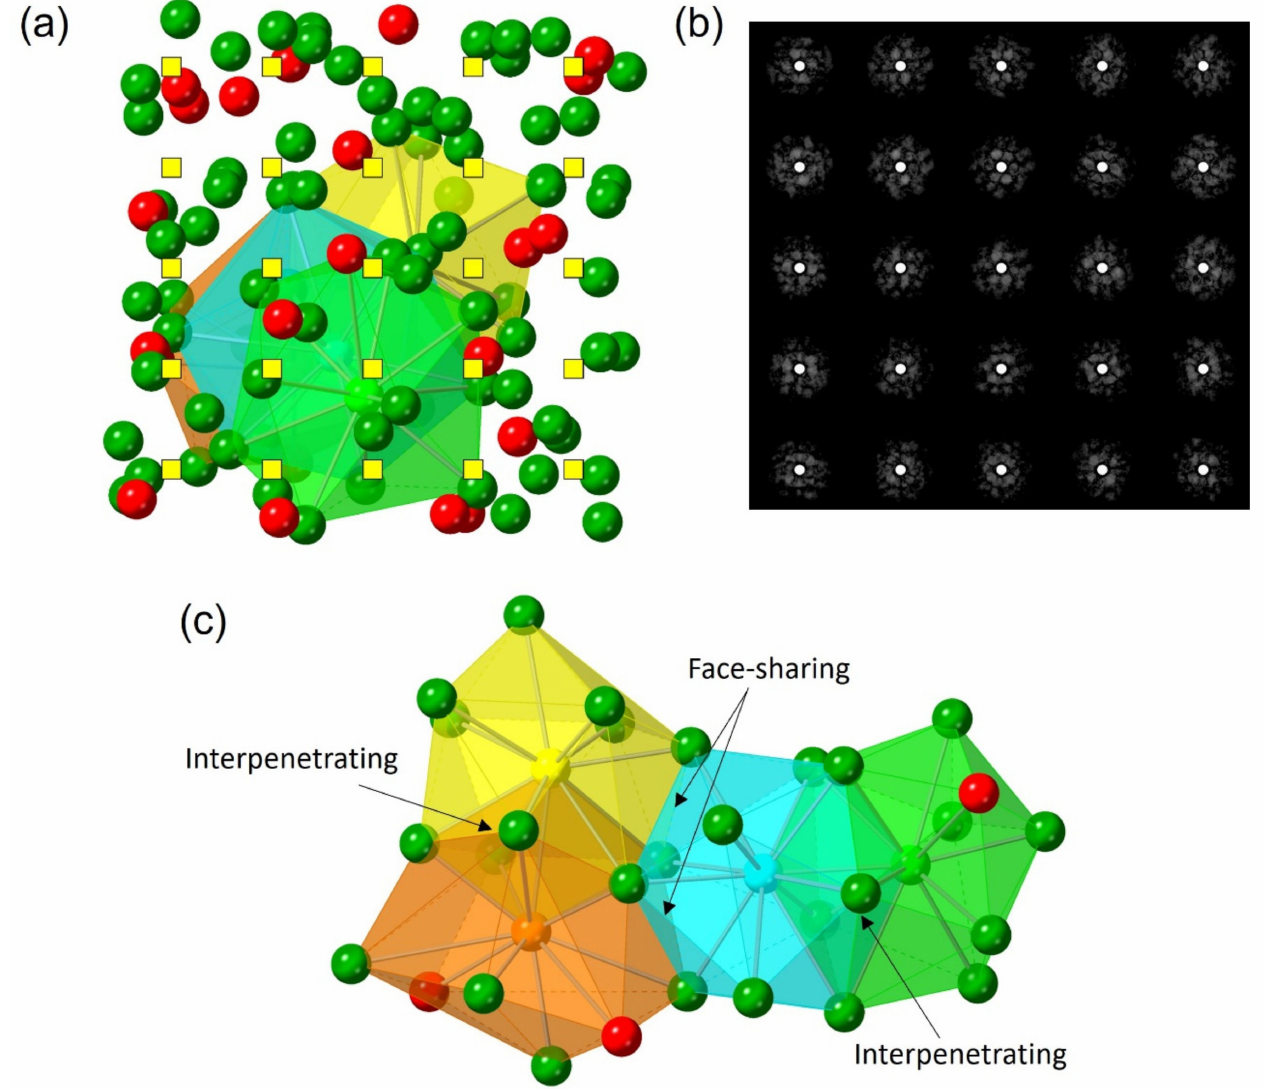
Figure 6. Analysis of another region of the same model. ( a ) Positions where the electron beam is virtually irradiated, ( b ) calculated electron diffraction patterns from the positions, and ( c ) aggregate of coordination